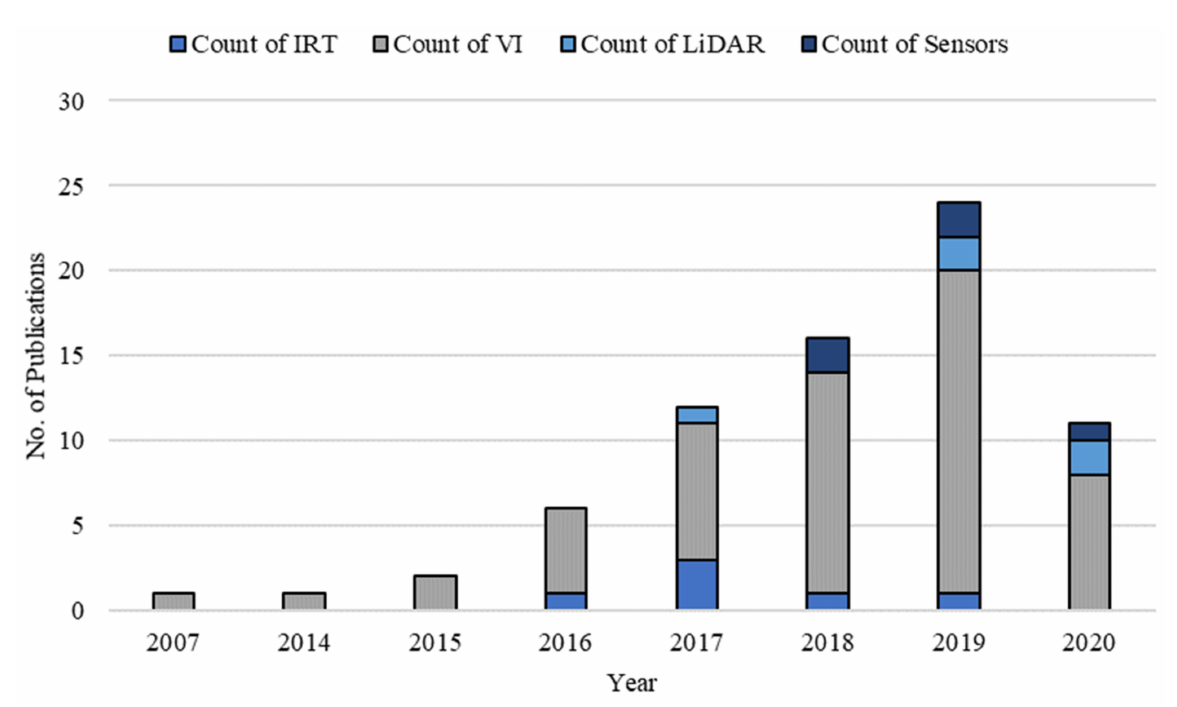
Figure 2. Yearly distribution of NDT-UAV technologies used for bridge condition